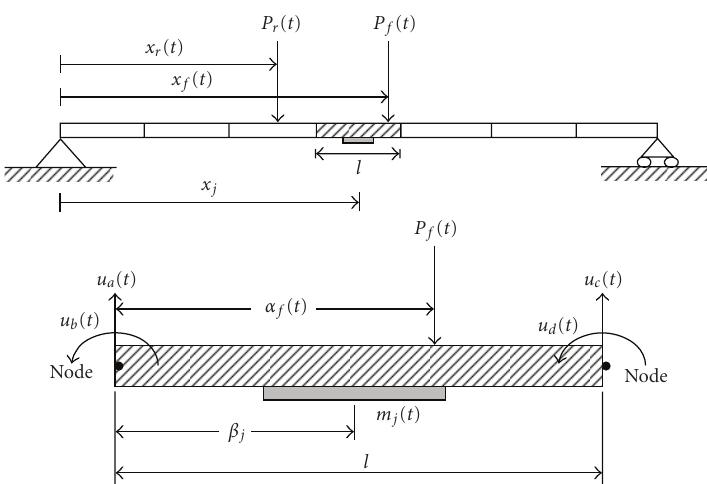
Figure 2: Bridge finite element model and local coordinates in beam